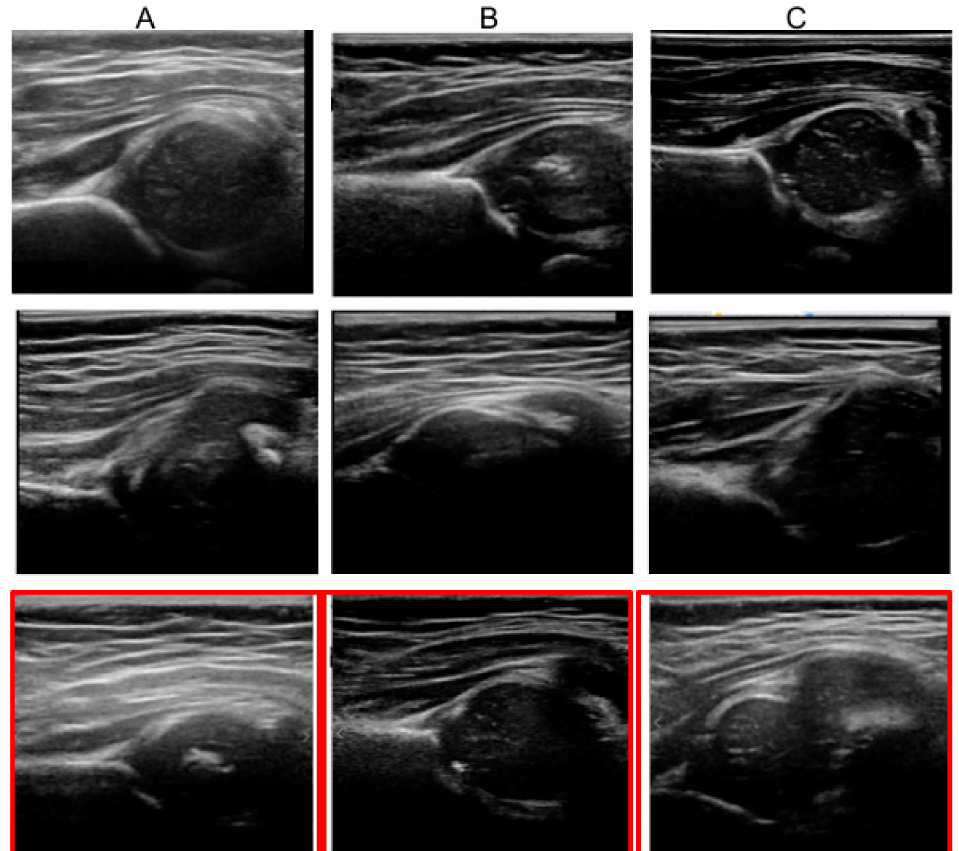
Figure 3. Examples of images analyzed by AI. Row 1: Images of high quality that were correctly identified AI. Row 2: Low-quality images correctly categorized as inadequate by AI. Row 3: Cases where AI failed are indicated with a red box. Images ( A , B ) were categorized as inadequate by AI and two human readers but were categorized as adequate by the expert reader (these images represent false positives in classification). Similarly, image ( C ) was classified as adequate by AI and 2 human readers, but inadequate by the expert reader (false